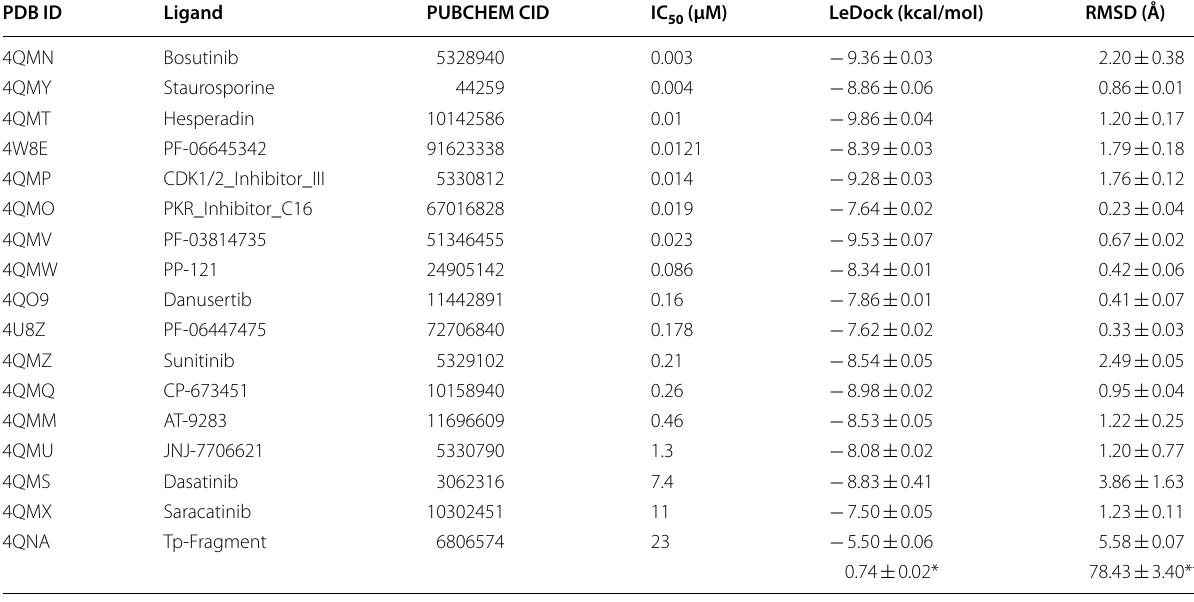
* Pearson correlation ( r ) value calculated using the docking scores and IC 50 values ** Percent of success rate for pose prediction within the best-scored